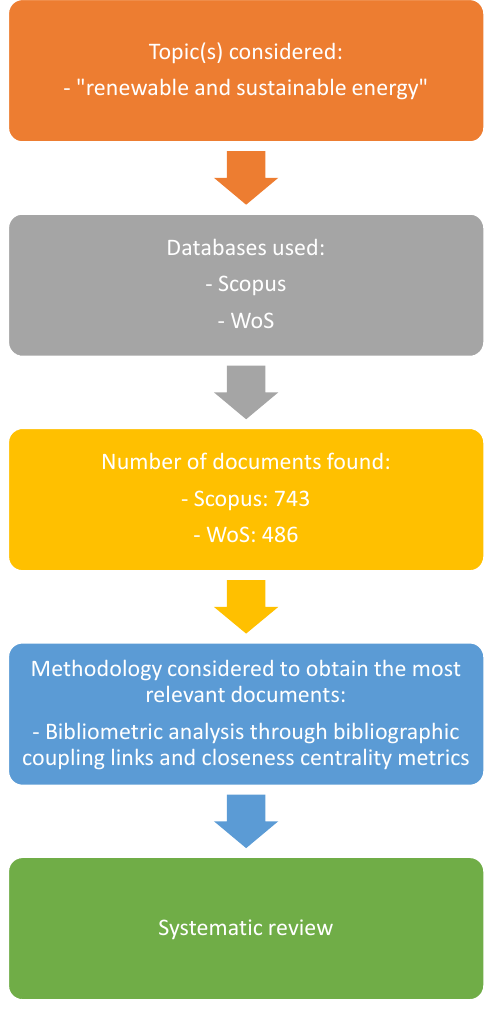
Figure 1. Steps to find the most relevant documents for systematic review, considering the proposed Biblio4Review approach.